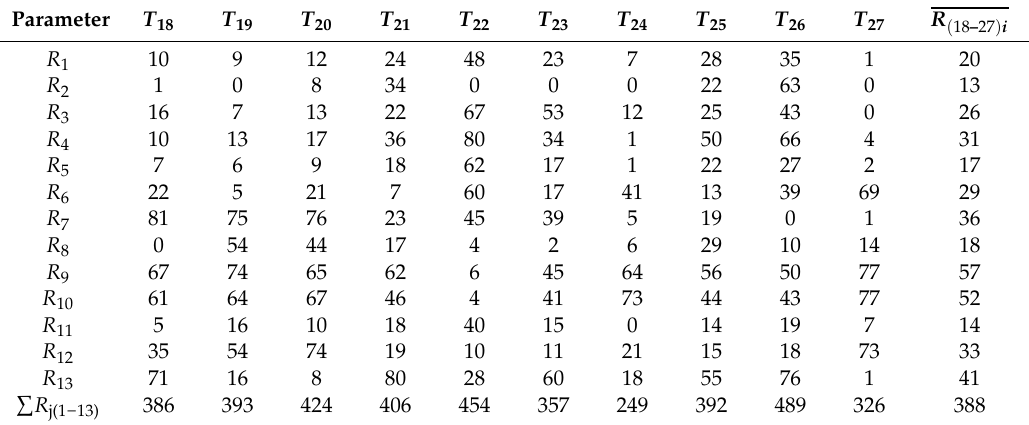
Table A18. Ranking of T j territories on land activity, Northwestern Federal